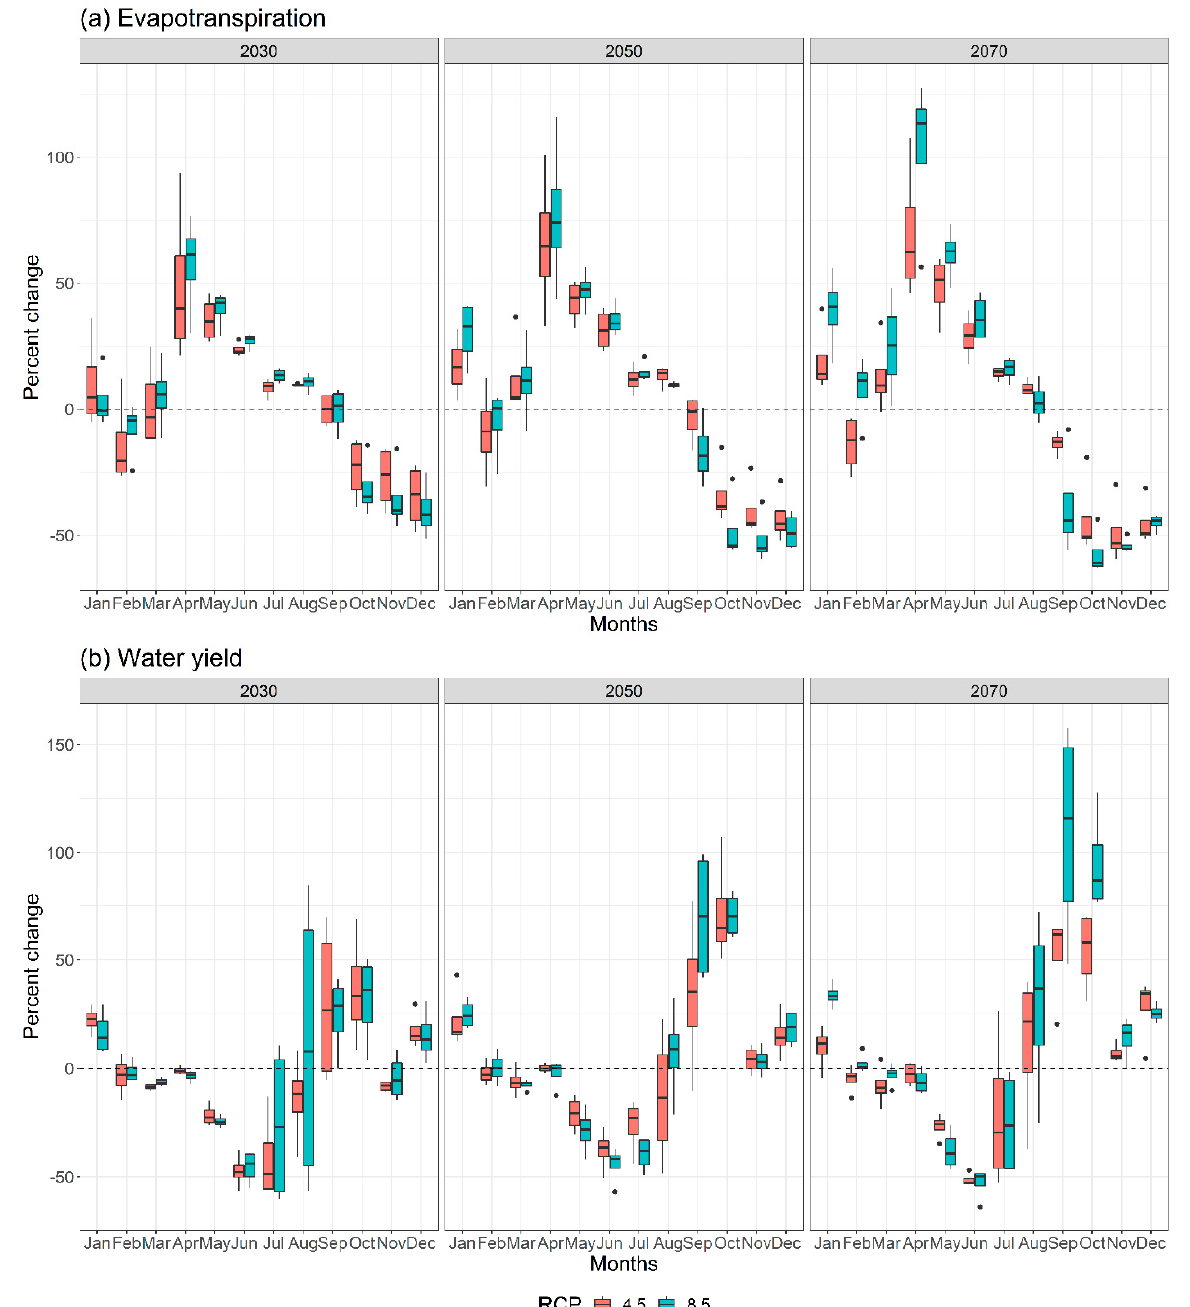
Figure 6. Projected monthly changes in water balance components ( a ) evapotranspiration, ( b ) water yield in Deckers Creek Watershed, Morgantown, West Virginia, USA. Box and whisker plot represent ensemble percentage change for four GCMs under two RCPs (RCP 4.5 and RCP 8.5). Projections are for 3 future periods of 20-year interval (2030 = 2031 − 2050, 2050 = 2051 − 2070, 2070 = 2071 − 2090). The dotted line represents the historical baseline of 1980 − 1999.